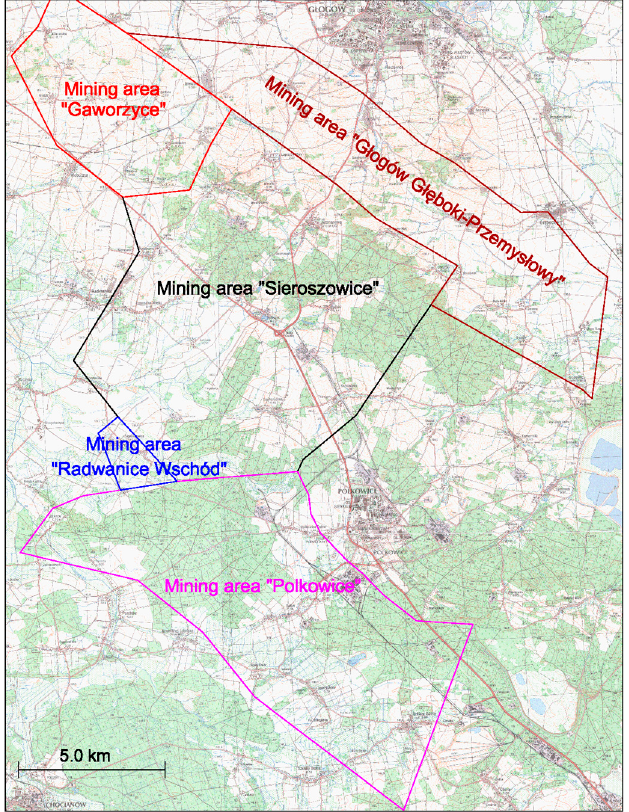
Figure 1. Location of the Mining Areas belonging to the Polkowice-Sieroszowice mine.